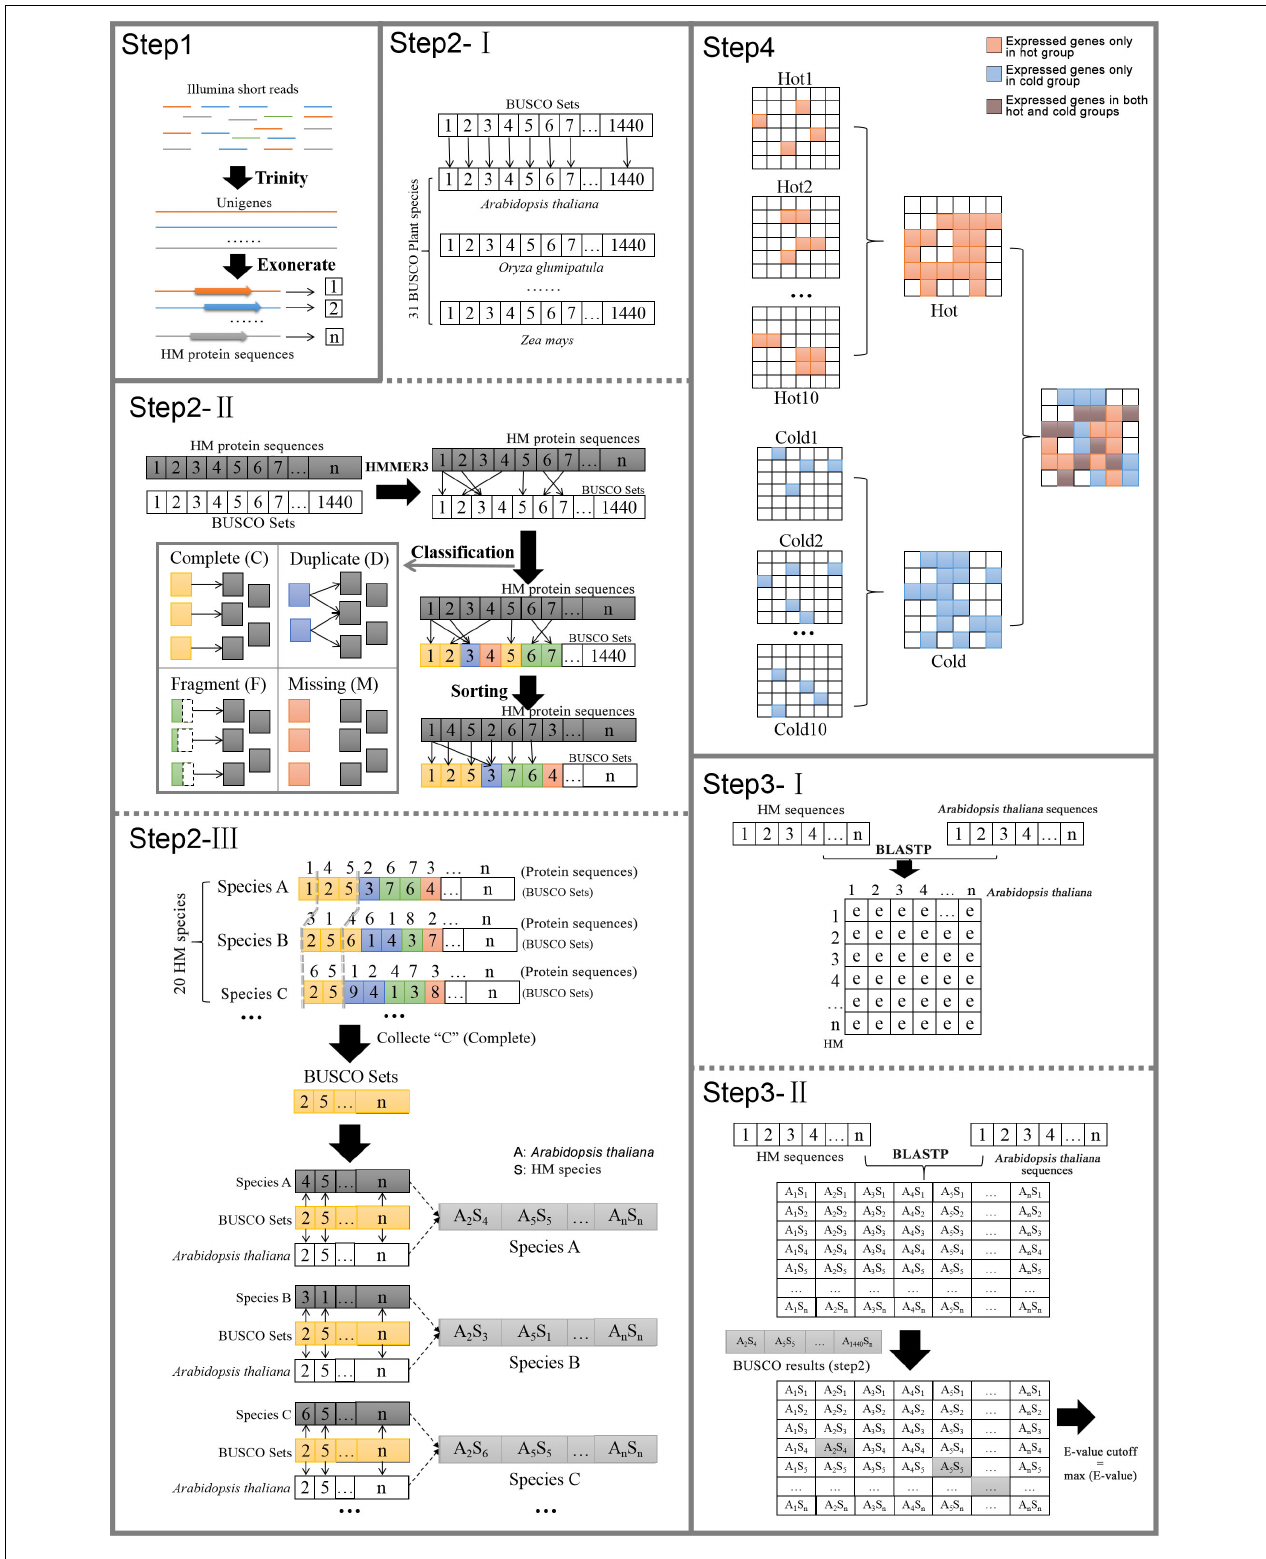
FIGURE 1 | Pipeline of cross-species gene annotation and selection of specific expressed genes.